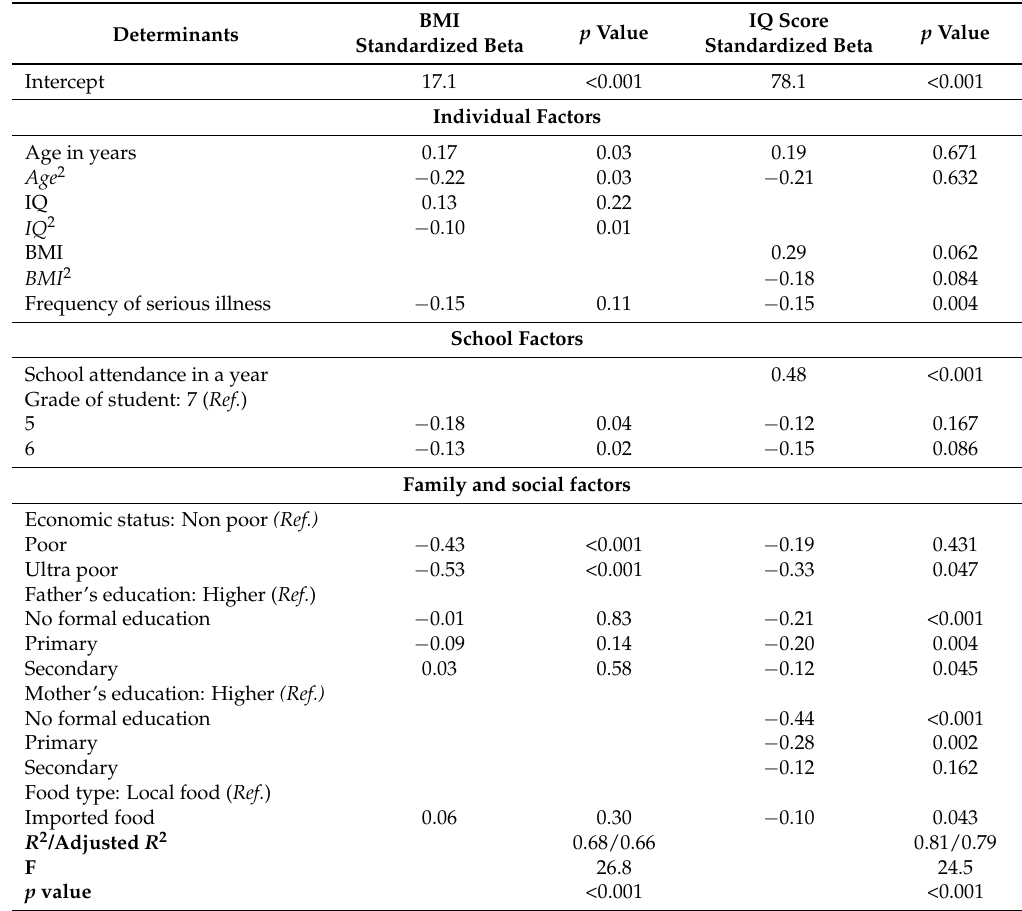
Table 2. Determinants of BMI and IQ score by multiple linear regression mixed